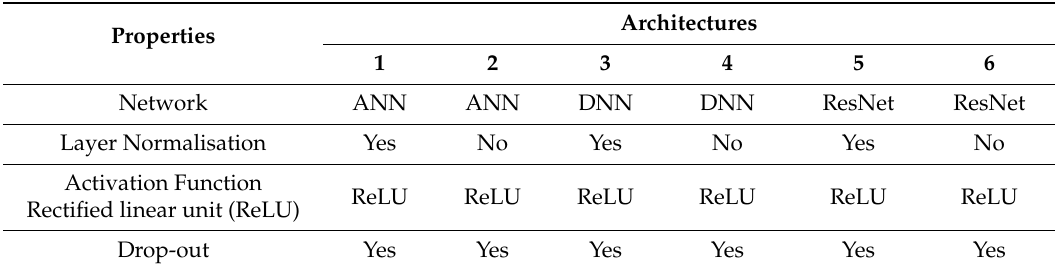
Figure 5. Schematic flowchart presenting the three machine learning approaches used to estimate FAGP concrete compressive strength. Table 3. Details of the setting of six investigated architectures from artificial neural network (ANN), deep neural network (DNN) and deep residual network